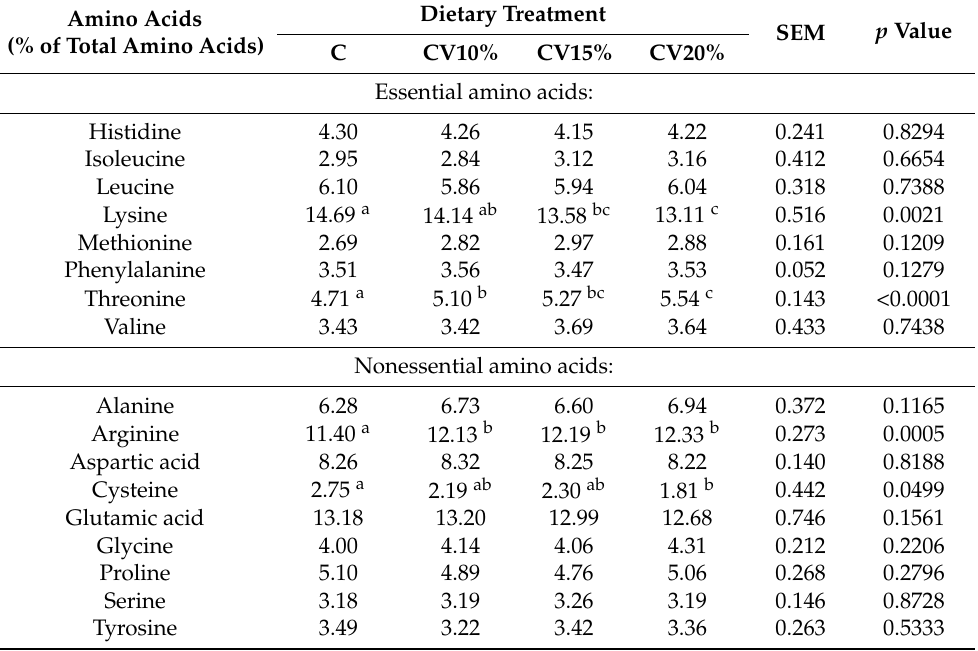
Table 5. Profiles of amino acids in breast muscle of broilers chickens fed different levels of C. vulgaris for 40